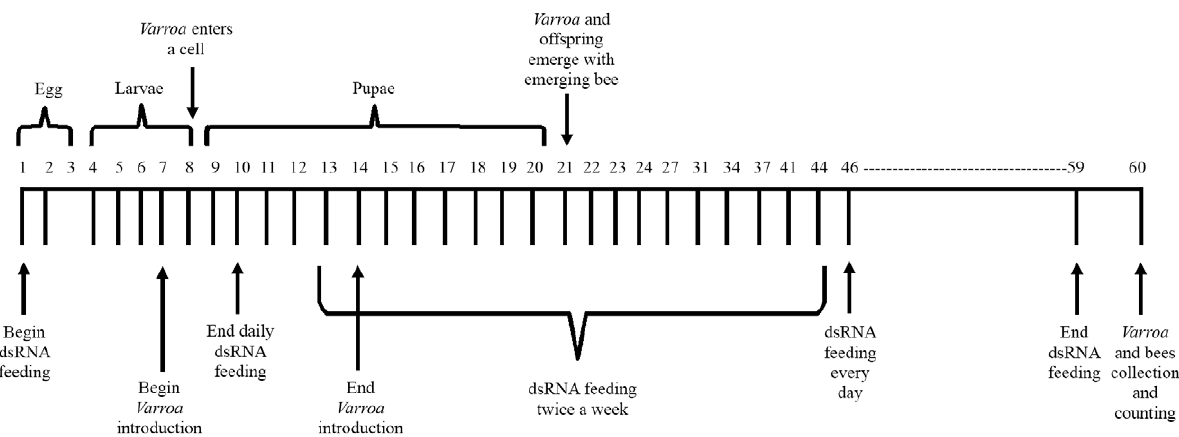
Figure 4. Schematic representation of the honey bee feeding regimen. The experiment lasted for 60 days. Top: schematic representation of a honey bee’s life cycle. Bottom: experimental procedures on a